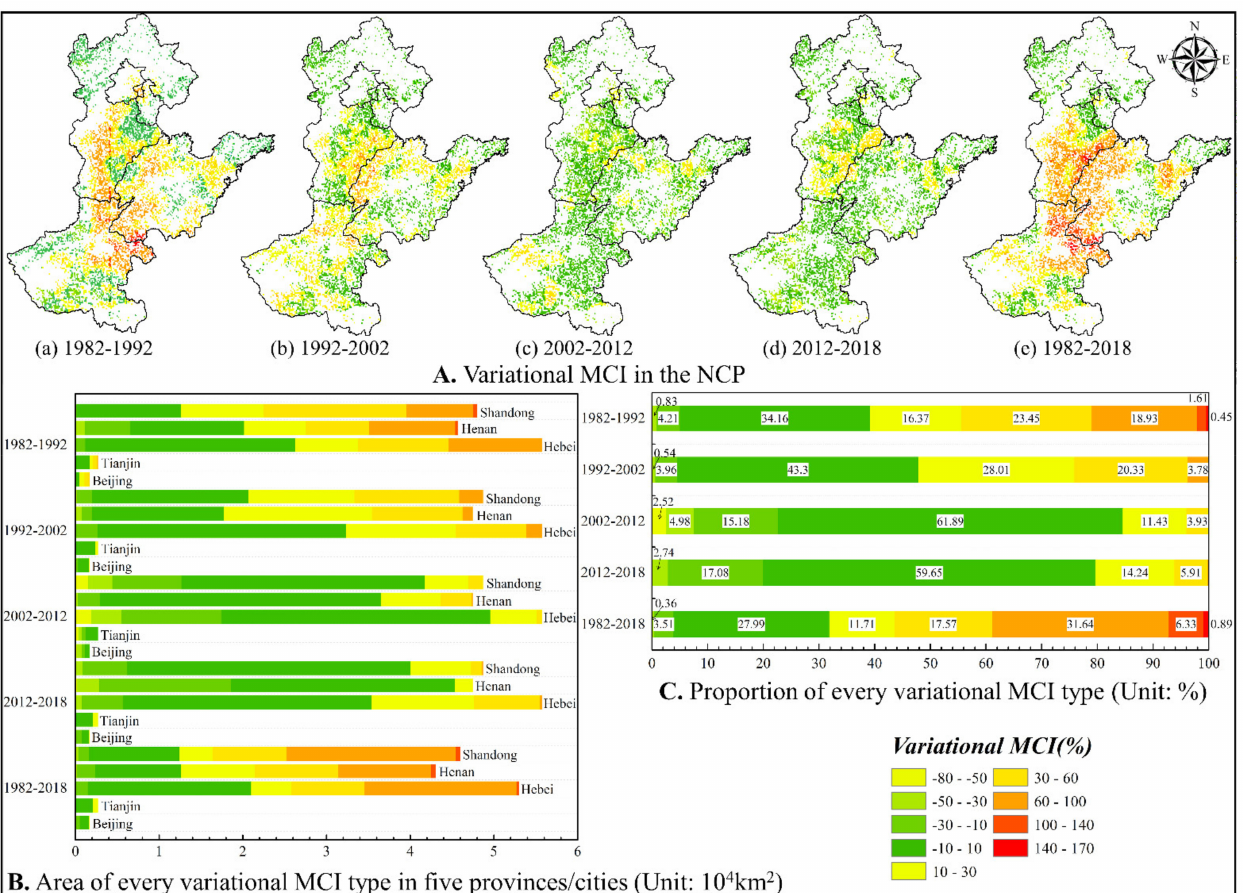
Figure 11. Annual variation in the CI on the NCP and in the different provinces and cities over different time